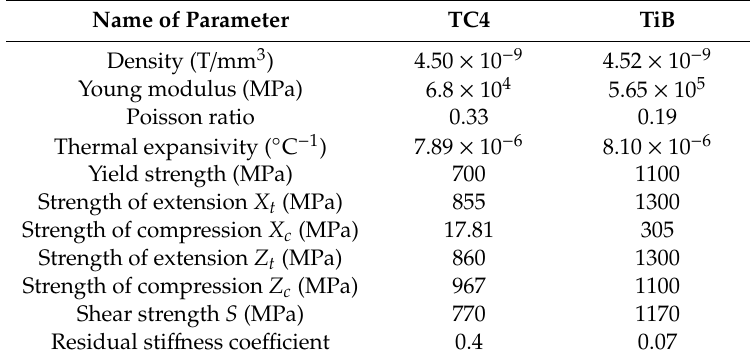
Table 1. Main parameters of TiBw / TC4 composites with 8.5%volume fraction of whiskers.